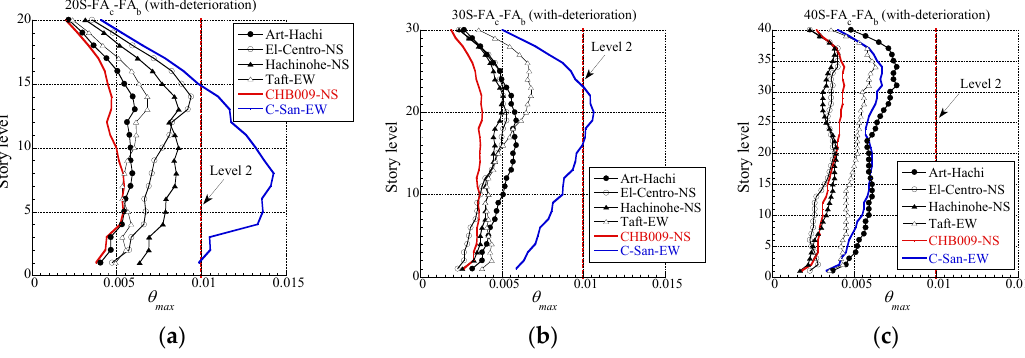
Figure 8. Maximum story drift angle of high ‐ rise SMRFs with compact members under Level 2 earthquakes. ( a ) 20S model; ( b ) 30S model; ( c ) 40S model.